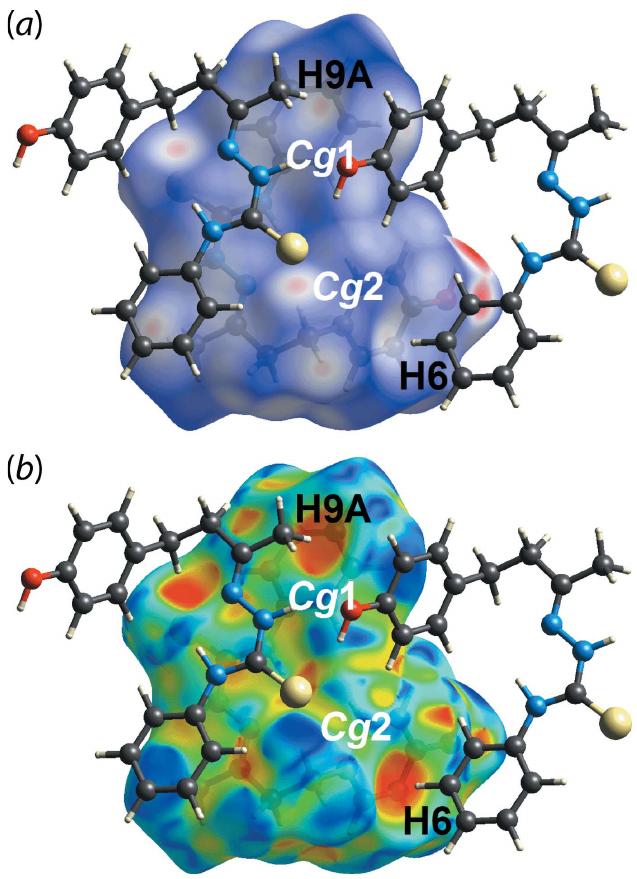
Figure 5 Views of the Hirshfeld surface mapped for (I) over ( a ) d norm in the range (cid:3) 0.490 to +1.188 arbitrary units and ( b ) the shape-index property, each highlighting the methyl-C9—H9 A (cid:4)(cid:4)(cid:4) (cid:2) (C2–C7; Cg 1) and phenyl-C6— H6 (cid:4)(cid:4)(cid:4) (cid:2) (C12–C17; Cg 2) interactions.